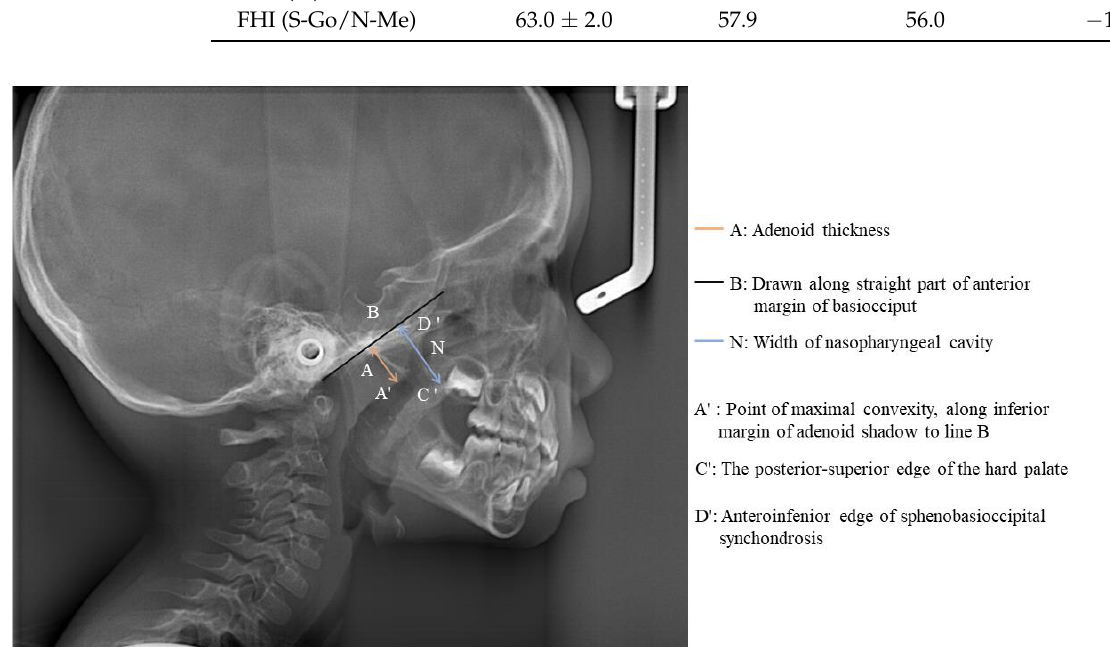
Figure 4. The initial and final radiographs. ( A ): Pre-treatment; ( B ): Post-treatment.